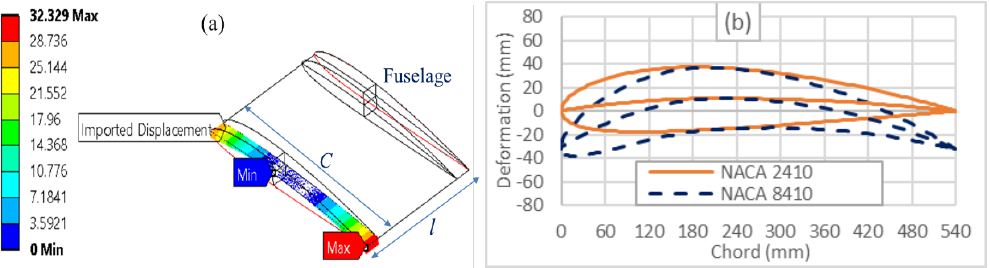
Figure 3. ( a ) Wing model with some important design parameters and ( b ) 2D airfoils comparison between NACA2410 and NACA8410.